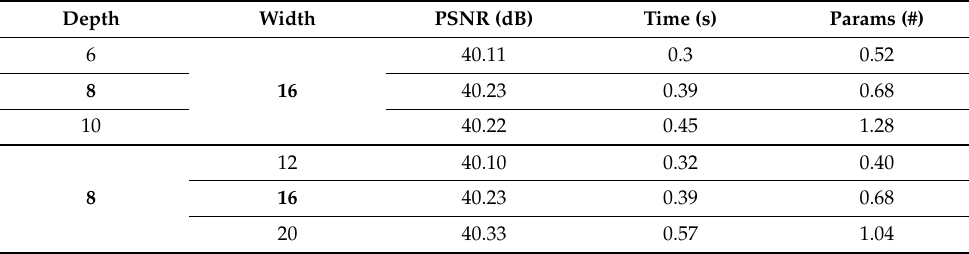
Table 8. Quantitative results under different network